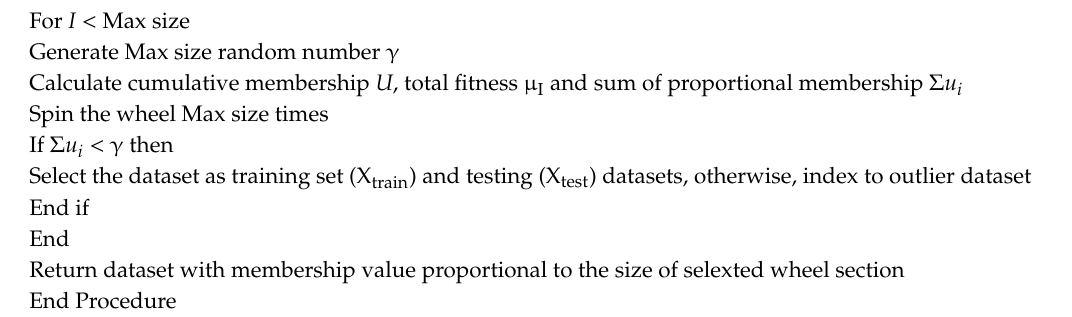
Algorithm 1: Fuzzy Roulette Wheel Selection with Membership